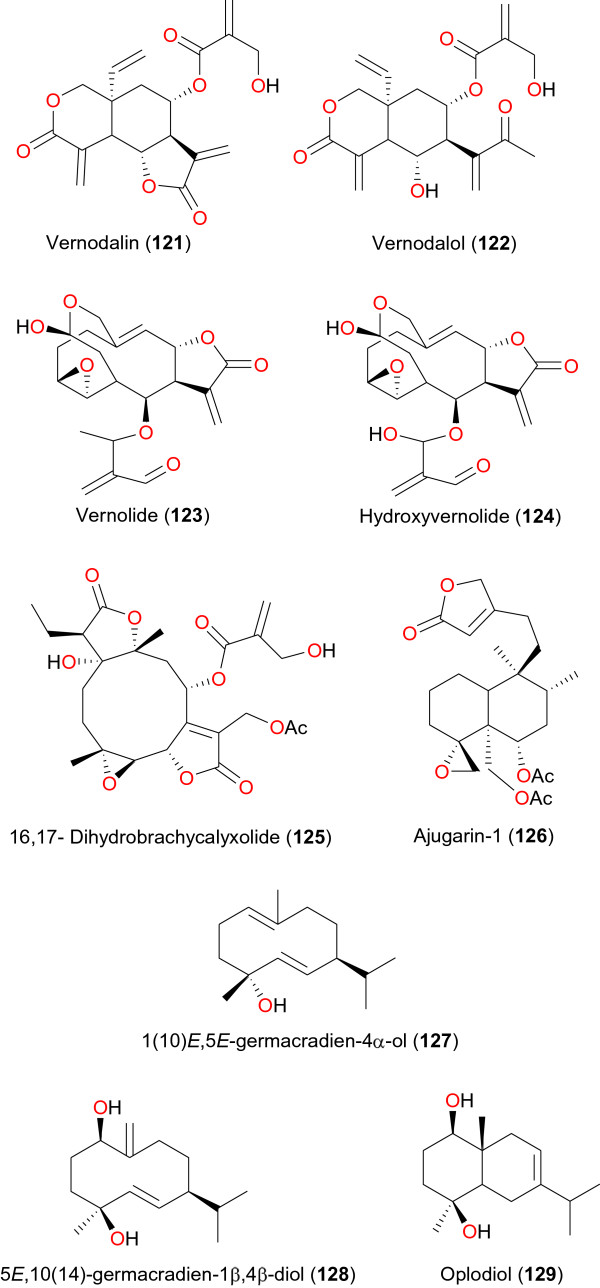
Some anti-malarial sesquiterpenes and sesquiterpene lactones from African medicinal plants - I.